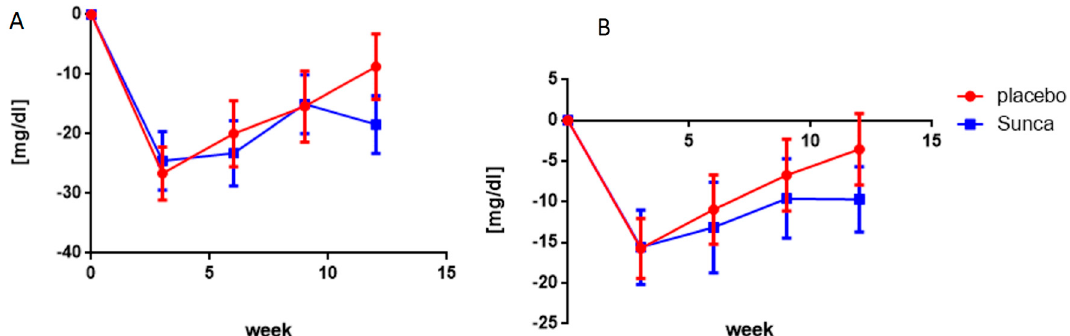
Figure 3. Changes in blood cholesterol ( A ) and LDL-cholesterol ( B ) at various intervals after consumption of either sunflower extract (in blue) or placebo (in red). Each symbol represents the mean ± s.e.m. of at least 17 observations.